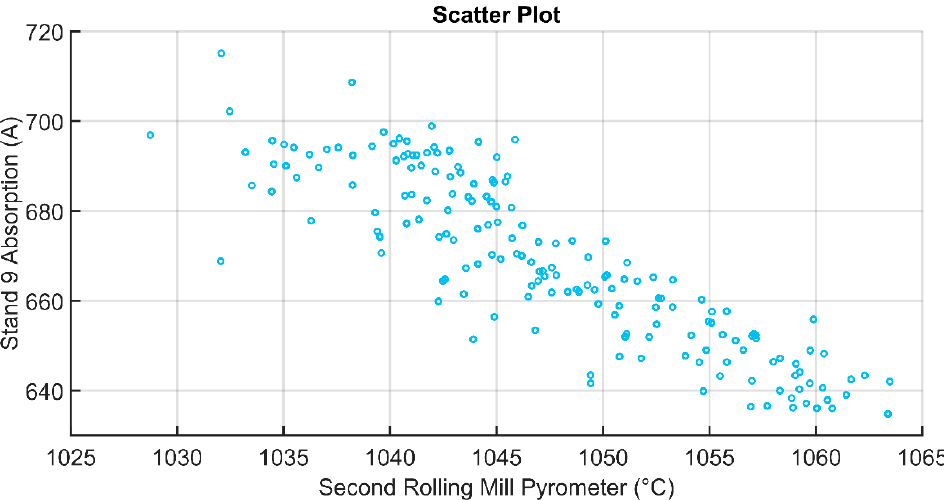
Figure 10. Scatter plot comparing the second rolling mill pyrometer and the absorption in stand 9.